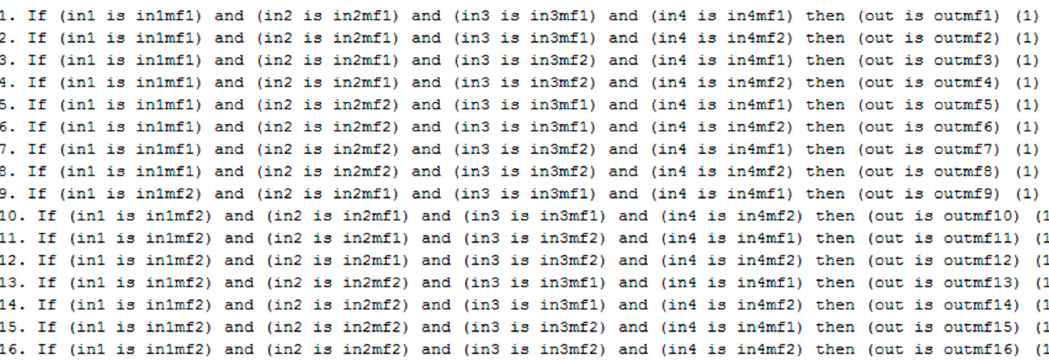
Figure 7. Fuzzy rules for the inverted pendulum.